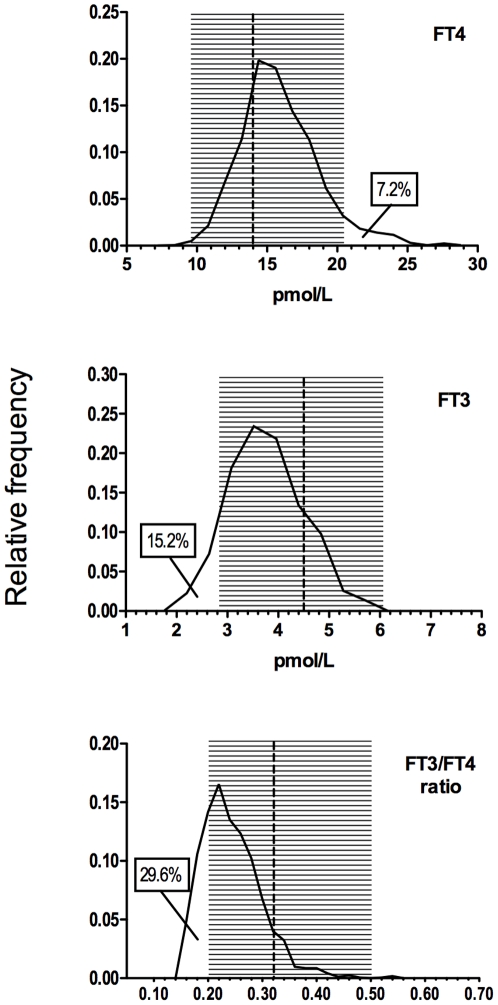
Free thyroid hormones and FT3/FT4 ratio frequency distribution.FT3 and FT4 serum levels and FT3/FT4 ratio distribution in 1,811 athyreotic patients under levothyroxine (L-T4) monotherapy. Shaded areas indicate the normal range (2.5–97.5 percentiles) calculated in 3,875 euthyroid controls. Vertical dotted lines indicate the median of the normal values. Percentages indicate the patients with values under or above the normal values.